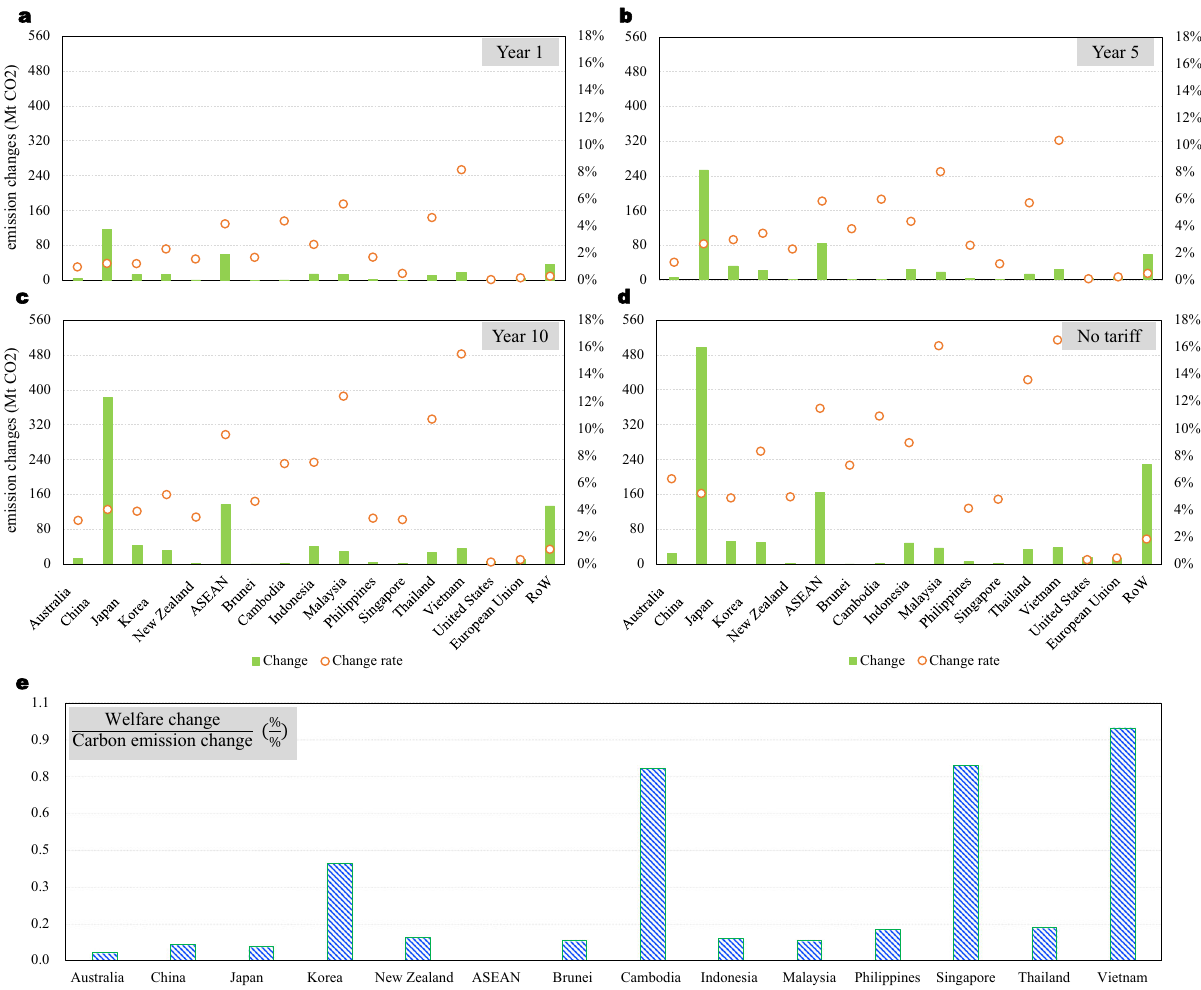
Fig. 3 CO 2 emission burdens of RCEP ’ s tariff reductions. a , b , c present the changes and change rates in the amount of CO 2 emissions emitted by different economies for the cases, in which the tariffs within the Regional Comprehensive Economic Partnership (RCEP) bloc declined to the level in year 1, 5, and 10 after the RCEP enters into force, respectively. d presents the corresponding results for the case in which trade in goods among RCEP members is ultimately duty-free. e gives the ratio of economic welfare change to the CO 2 emission change rate for RCEP members (Supplementary Table 10). ASEAN denotes the Association of Southeast Asian Nations. Here, Laos and Myanmar are still classi fi ed into the rest of the world (RoW) for the same reason as given in the note of Fig.